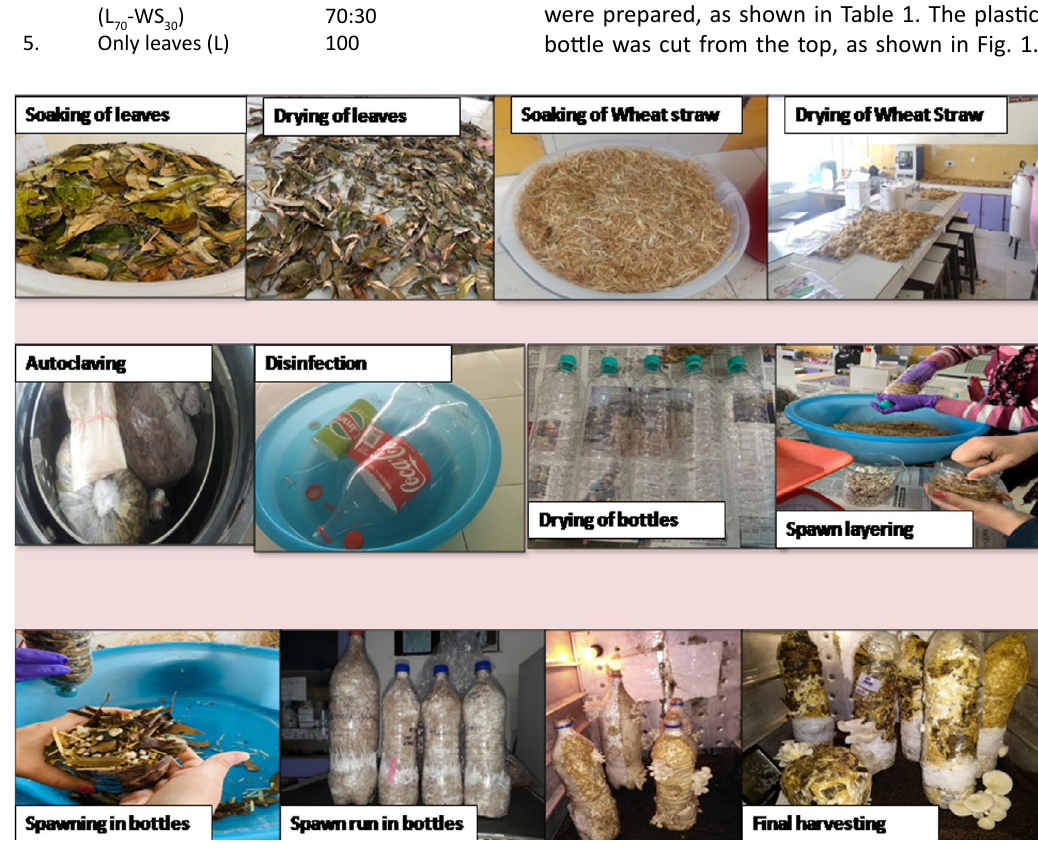
Fig. 1. Schematic representation of steps involved in the cultivation of Pleurotus ostreastus from agricultural and leaf waste in used plastic